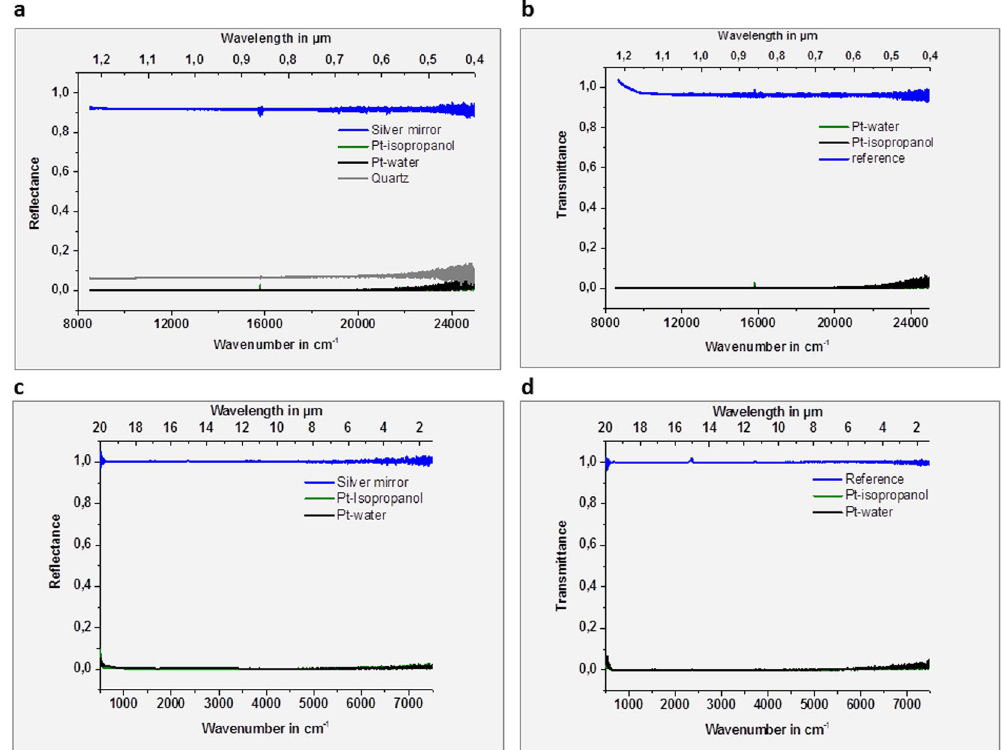
Figure 3. Light transmission characteristics. ( a , b ) Reflectance and transmittance Vis-NIR spectra of the platinum powder synthesized in water ( a ) and in isopropanol ( b ), respectively; the powder was immobilized on quartz slides; ( c , d ) Reflectance and transmittance FTIR spectra of the platinum powder synthesized in water ( a ) and in isopropanol ( b ), respectively. Reference reflectance: silver mirror; reference transmittance: air (blue